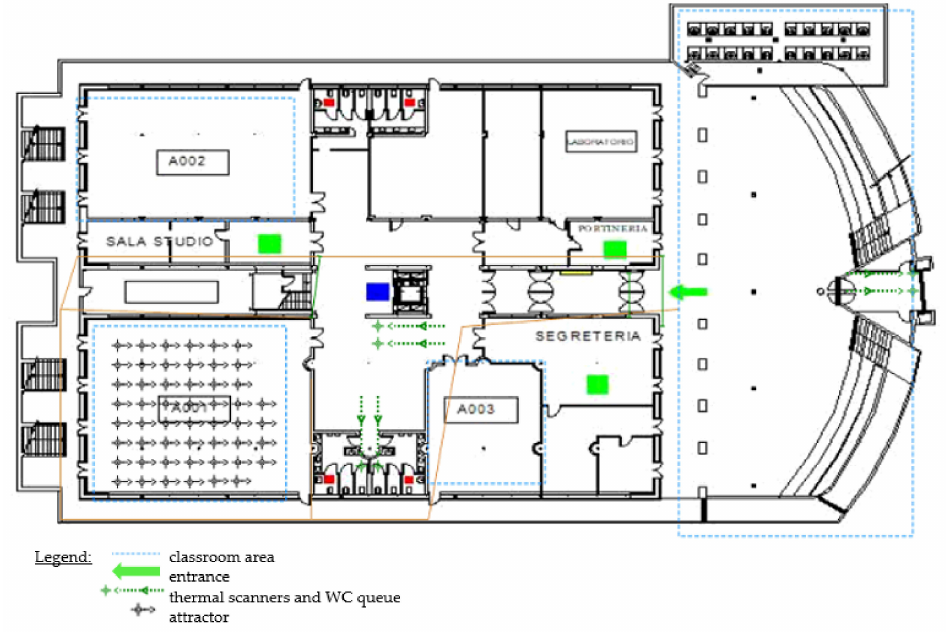
Figure 5. DES model